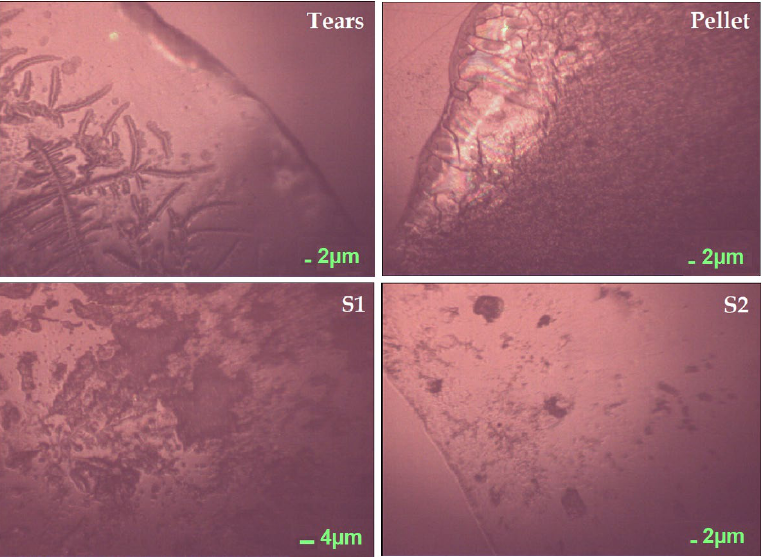
Figure 1. Pictures of the protein extraction phases acquired by the optical microscope integrated within the Raman instrument. Tears, unprocessed sample; S1, aqueous layer; S2, organic solvent layer; P, pellet.